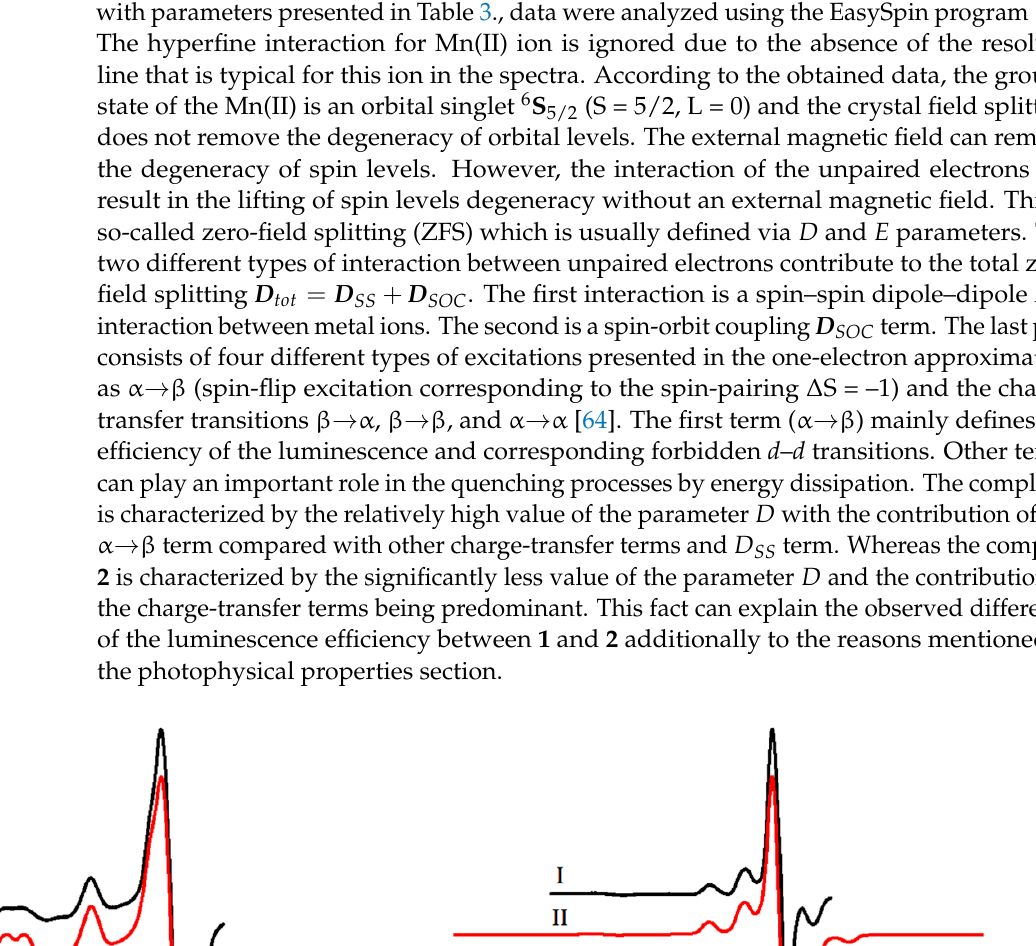
Figure 4. Representation of the energy absorption, transfer, and emission processes in 1 and 2 ( —absorption, —internal conversion and intersystem crossing transition, —emission, —transfer from [H 2 DPEphos] 2+ to [MnX 4 ] 2- , —non-radiative relaxation).